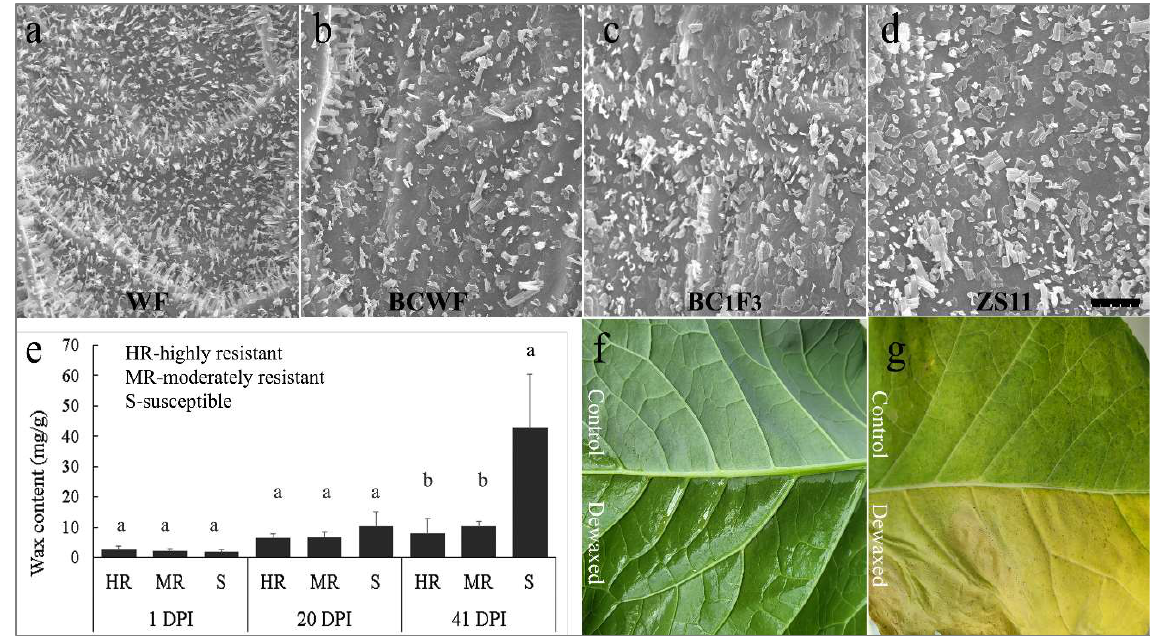
Figure 3. Comparison of the shape and content of the cuticular wax in different leaves and the effect of partially washing off the surface wax. The accessions in ( a – d ) are ‘WF’, ‘BCWF’, the moderately resistant plant in the BC 1 F 3 population and ‘ZS11′, respectively. The cuticular wax of ‘BCWF’ and ‘WF’ is needle-like. The wax crystals of resistant plants in ‘WF and ‘BCWF’ are tubular-like or short and tubular, while that of ‘ZS11′ is mostly flake-like. The cuticular wax content in the leaves of plant accessions of different resistance levels ( e ). Different letters indicate significant differences ( p < 0.05). Washing off surface wax from a half blade of ‘WF’ young leaf ( f ) leads to early senescence but not PM susceptibility ( g ).